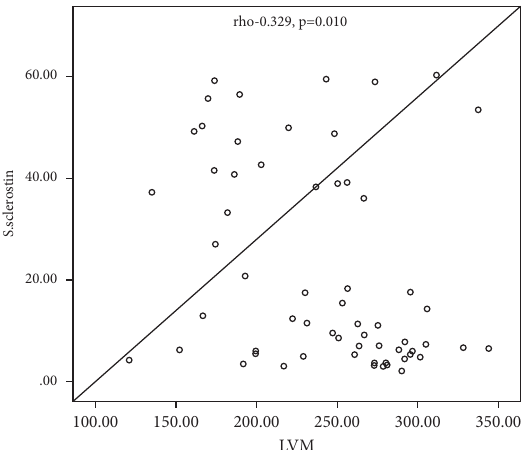
Figure 1: Linear negative correlation between the left ventricular mass and serum sclerostin level.